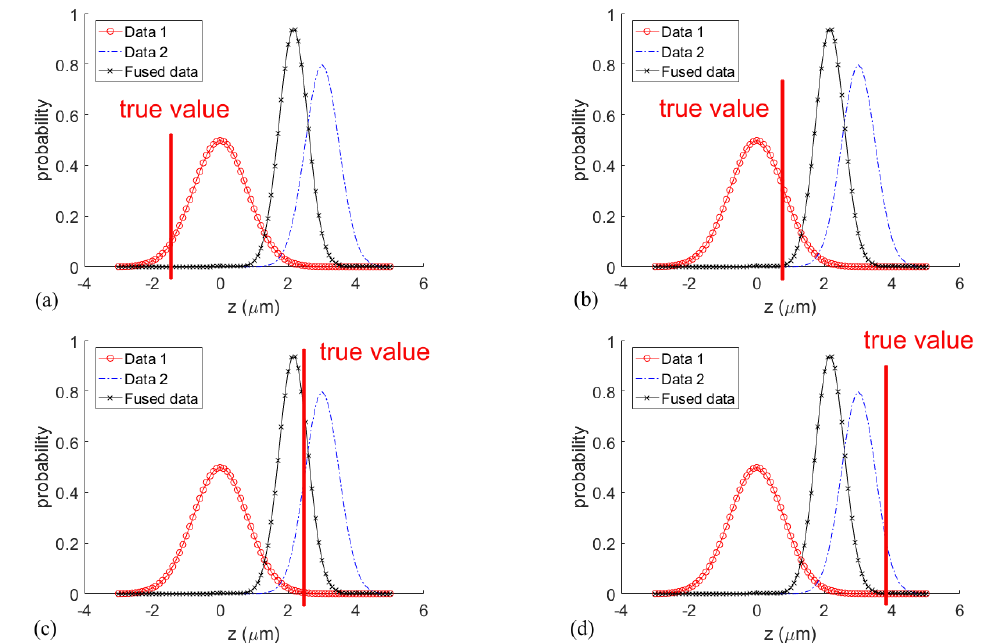
Figure 3. Influence of systematic error, random error and the true value for the fused result: ( a ) measurement with large systematic error but small random error, fused with measurement with small systematic error but large random error, Tv < M 1 < M 2; ( b ) measurement with large systematic error but small random error, fused with measurement with small systematic error and large random error, M 1 < Tv < M 2 (bias to M 1); ( c ) measurement with small systematic error and small random error, fused with measurement with large systematic error and large random error, Tv < M 1 < M 2 (bias to M 2); and ( d ) measurement with small systematic error and small random error, fused with measurement with large systematic error and large random error, M 1 < M 2 < Tv